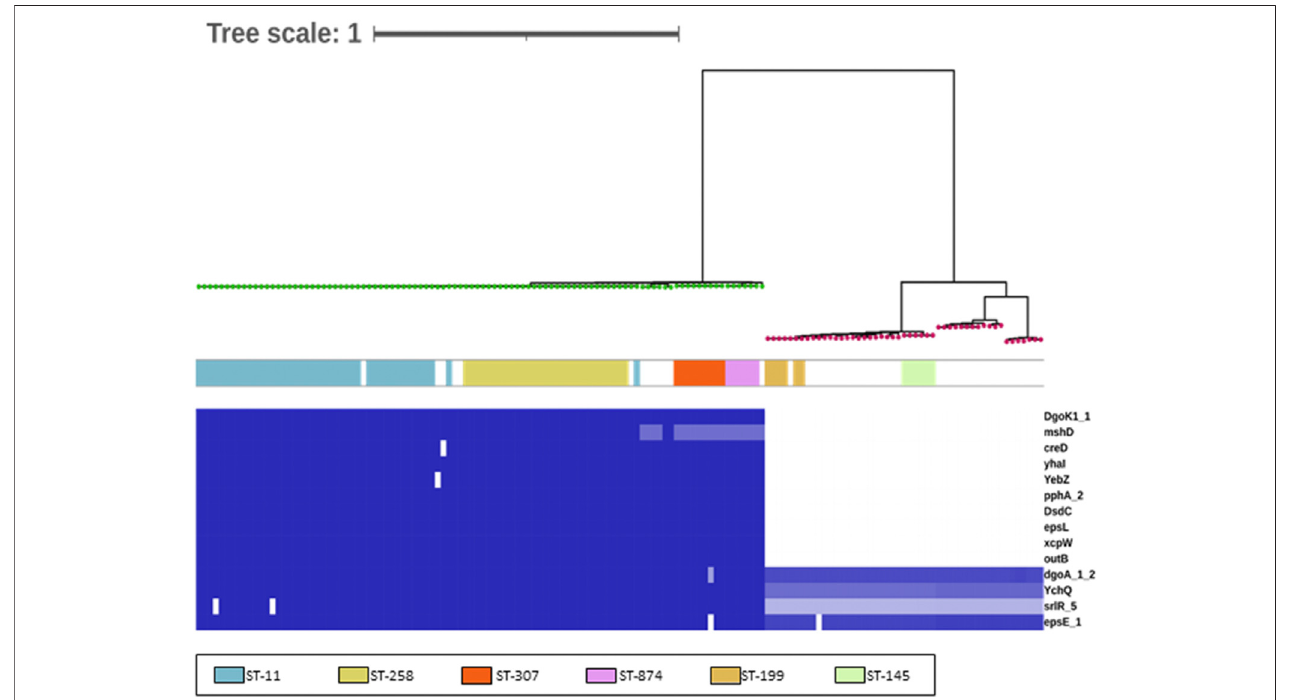
FIGURE1| Identi fi cation ofdiscriminatorygenetargets for K.pneumoniae .Thismatrixwasgeneratedusing BLAST(Abricate) using an80%identity andcoverage thresholdtoidentifypotentialvariation. Intensityoftheblue heatmapindicates identityrelativetoquery sequences ( Supplementary FileS2 ) (blue=100%,white=0%/ absence).Genesencodedbyboth Klebsiella speciesarealsolisted,forreference(bottom4).Thegenomesareorderedaccordingtothebranchingproducedusingcore genome SNP as identi fi ed using ParSNP and FastTree. The green nodes are K. pneumoniae genomes, and the red nodes, K. oxytoca genomes. The colors indicate the six sequence types (STs) identi fi ed in the Klebsiella included in the